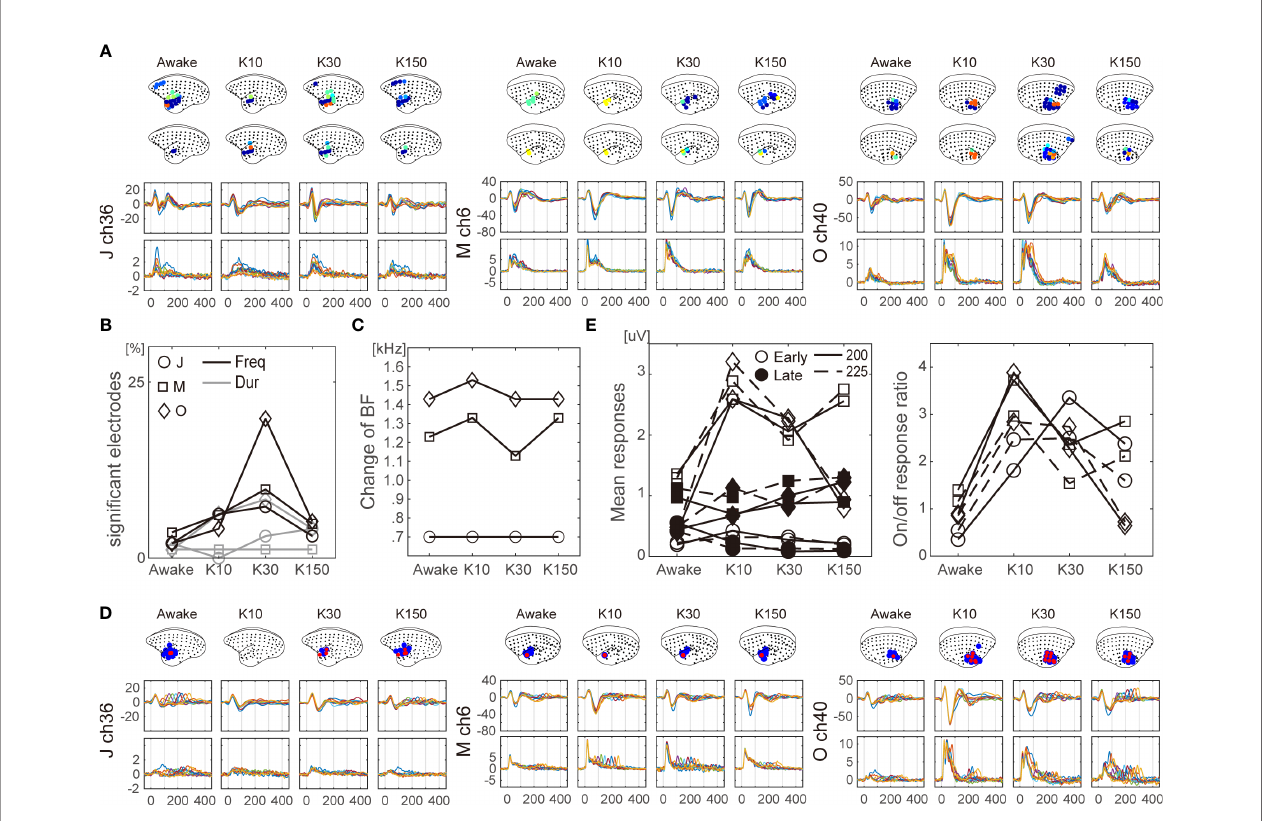
FIGURE 5 | The effects of ketamine on auditory feature processing over time following ketamine administration. (A) Changes in cortical maps for frequency preference of LF (top brain insets) and HG (bottom brain insets). The LF and HG signals of representative electrodes for LF and HG are shown. The dot and line colors represent each frequency. (B) Changes in the number of signi fi cant electrodes in terms of frequency preferences (black lines), and offset responses (gray lines). Data from monkey J (circle), M (square), and O (cross). Changes in BF (C) . (D) Changes in cortical maps for offset responses of LF (blue) and HG (red) (top). The LF (middle) and HG (bottom) signals of representative electrodes for LF and HG are shown. The dot and line colors indicate each duration. (E) Means of onset (0 – 200 ms; fi lled markers) and offset (200 – 400 ms; open markers) responses for the tones with 200 (solid lines) and 225 ms (dashed lines) (left). On/off response ratio